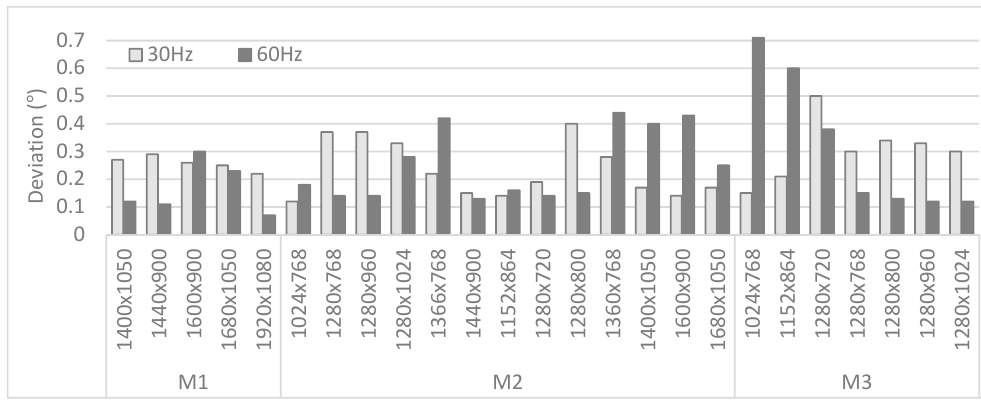
Figure 7. Deviations (visual angle) computed on different monitors for both 30 Hz and 60 Hz set-ups.